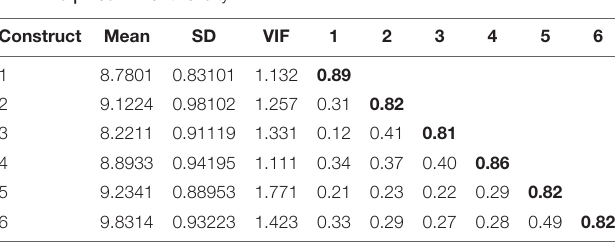
TABLE 5 | Discriminant validity. Construct